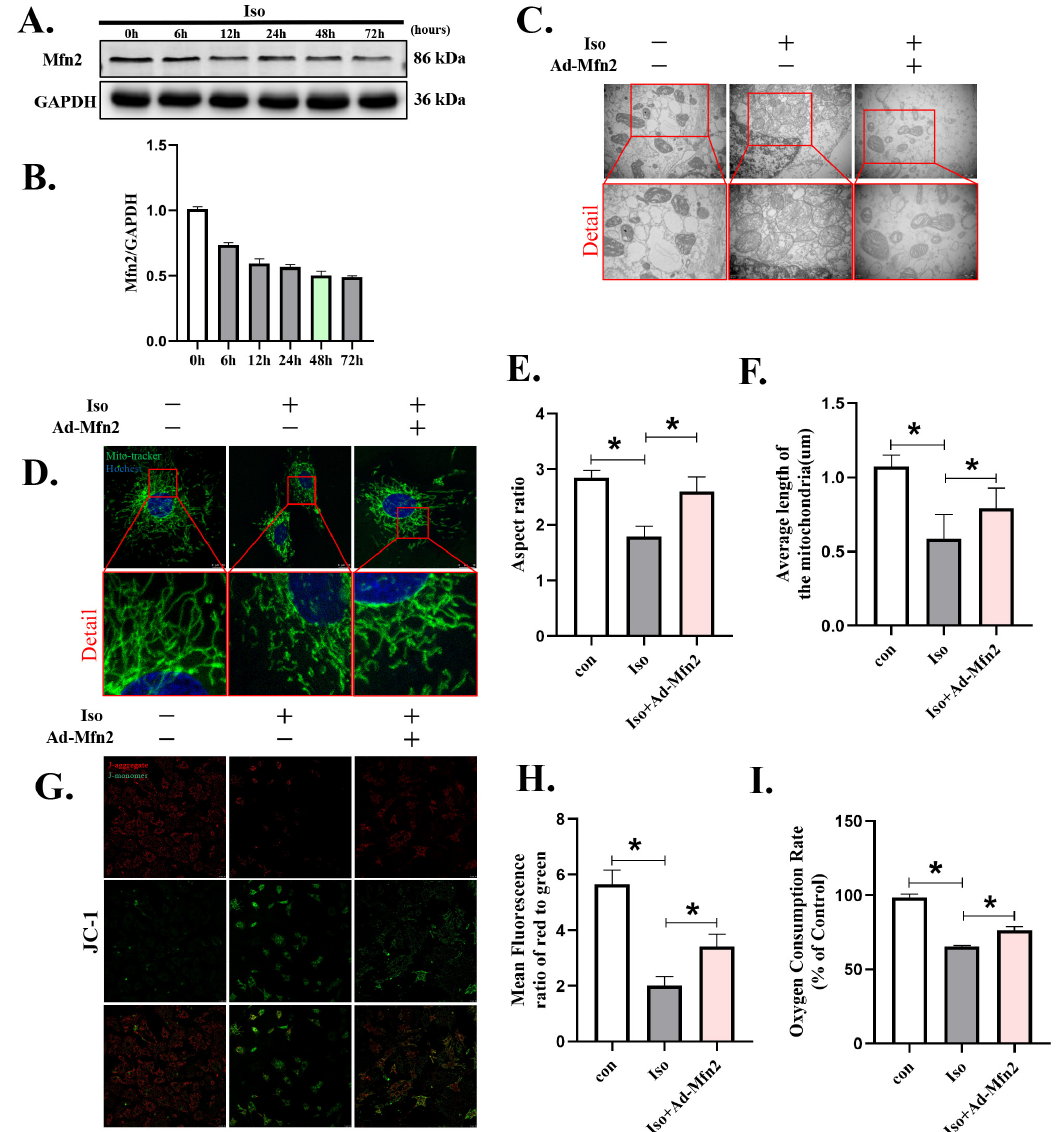
Figure 4. Overexpression of Mfn2 attenuated isoprenaline-induced cardiomyocyte injury by promoting mitochondrial fusion. Adenoviruses Ad-Mfn2 and Ad-control were used to transfect cardiomyocytes and then were stimulated with Iso (10 µM) for 48 h. ( A , B ) Western blot showing the expression of PINK1 over time. ( C ) Mitochondrial morphology in cardiomyocytes was shown by TEM. Details of mitochondrial structures are shown in the red frame. ( D – F ) Representative immu- no fl uorescence images of mitochondrial morphology. Mitochondria are shown in green, and nuclei are shown in blue. ( G , H ) Fluorescence images of MMP was detected by JC-1 tracker. J-aggregate staining is shown in red and J-monomer staining is shown in green. ( I ) Mitochondrial respiration was measured using extracellular oxygen consumption assay kits to assess oxygen consumption rate. Statistical analyses ( A – I ) were performed by one-way ANOVAs followed by Dunne tt ’s test post-hoc tests. Data are presented as the mean ± SD. (n = 3). * p < 0.05.